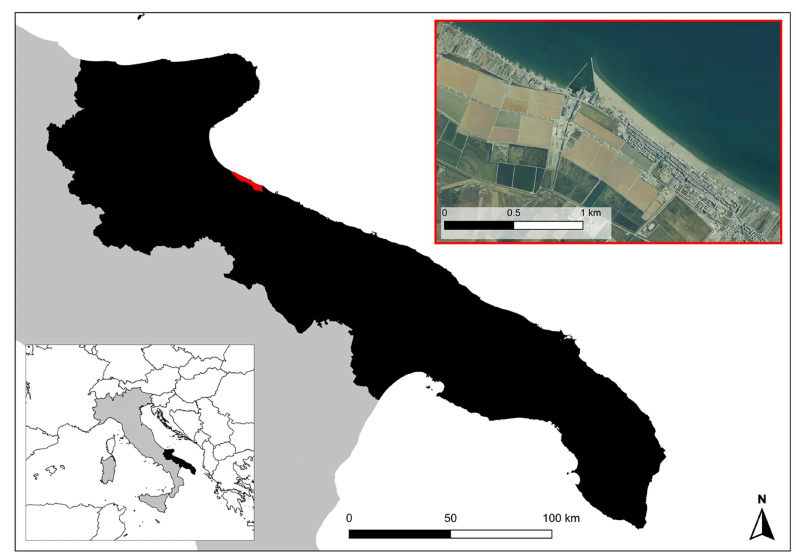
Figure 3. Framing the study area of Margherita di Savoia (Puglia Region, Southern